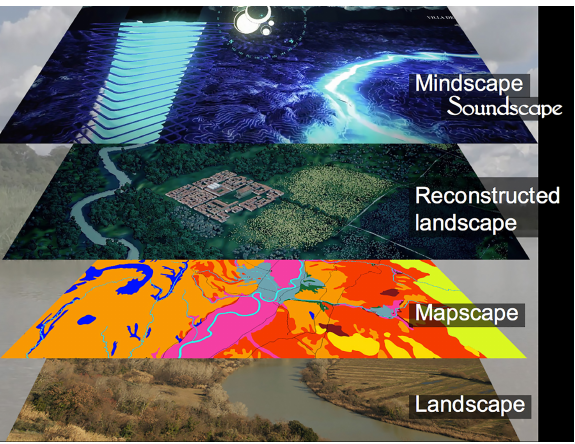
Figure 8. Landscape virtual museum. Levels of